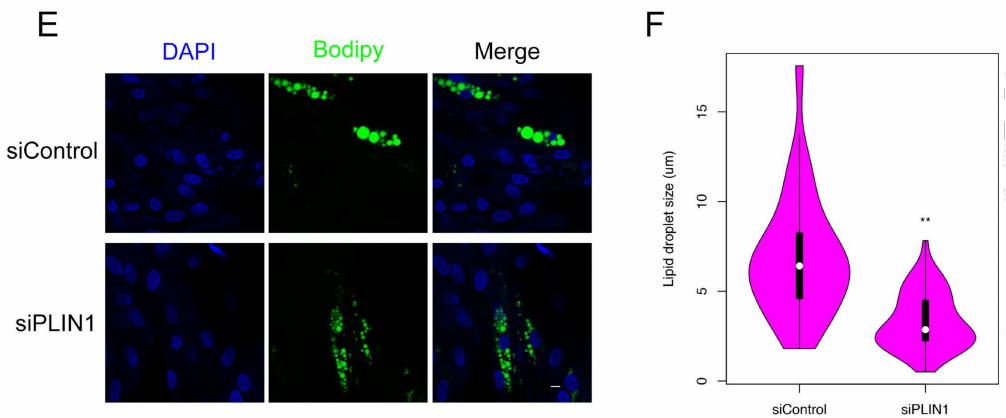
Figure 8. PLIN1 knockdown resulted in decreased triglyceride (TG) level and lipid droplet(LD) size. ( A ) Real-time quantitative reverse transcription polymerase chain reaction (qRT-PCR) analysis for PLIN1 messenger RNA (mRNA); ( B , C ) Western blotting analysis of PLIN1 protein expression in porcine adipocytes transfected with siControl or siPLIN1 after 48 h; ( D ) Measurement of TG level in porcine adipocytes transfected with siControl or siPLIN1 after 48 h; ( E ) Representative images showing morphology; and ( F ) vioplot showing statistical analysis of LD size in porcine adipocytes transfected with siControl or siPLIN1 after 48 h. Lipid droplets were stained with Bodipy (green). Nuclei were stained with DAPI (blue). Scale bars: 10 µ m. All data are presented as mean ± SE, ** p <